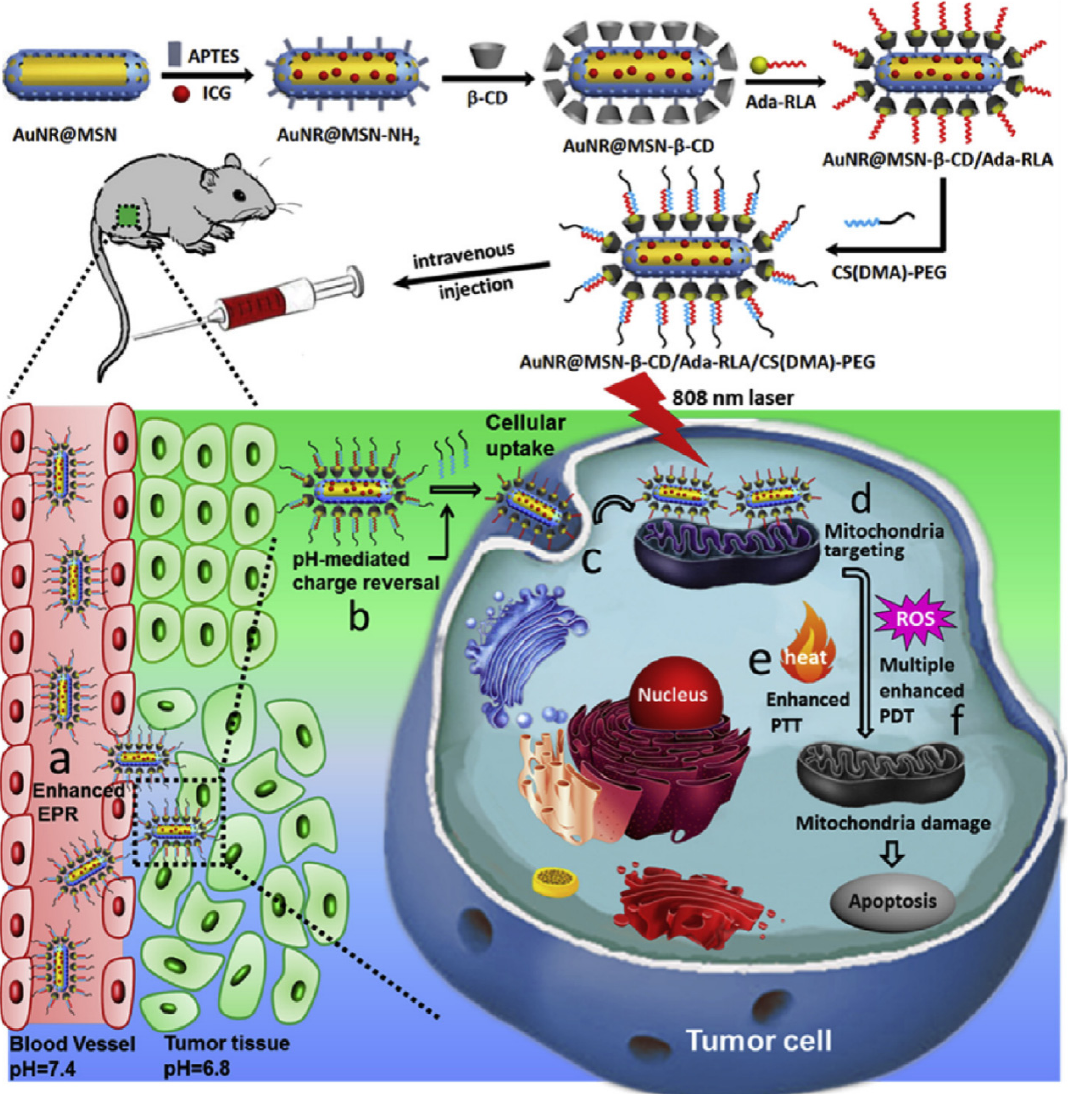
Figure 5. Schematic illustration of the preparation of the AuNR@MSN-based multifunctional nanoplatform and its work process in vivo: ( a ) tumor accumulation of nanosystem via the EPR effect; ( b ) removal of PEG-modified chitosan by slight acidity and exposure of the functional [RLARLAR] 2 peptide; ( c ) peptide-mediated internalization and ( d ) mitochondrial targeting; ( e ) NIR light-mediated enhanced photothermal and ( f ) photodynamic therapy. (Adapted with permission from Ref. [62]. Copyright 2018, Elsevier).